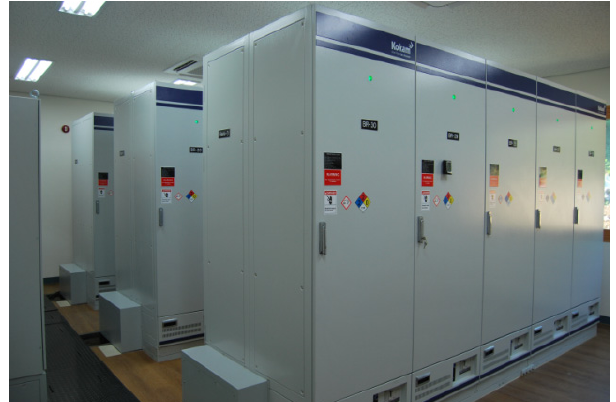
Figure 6. Li-ion